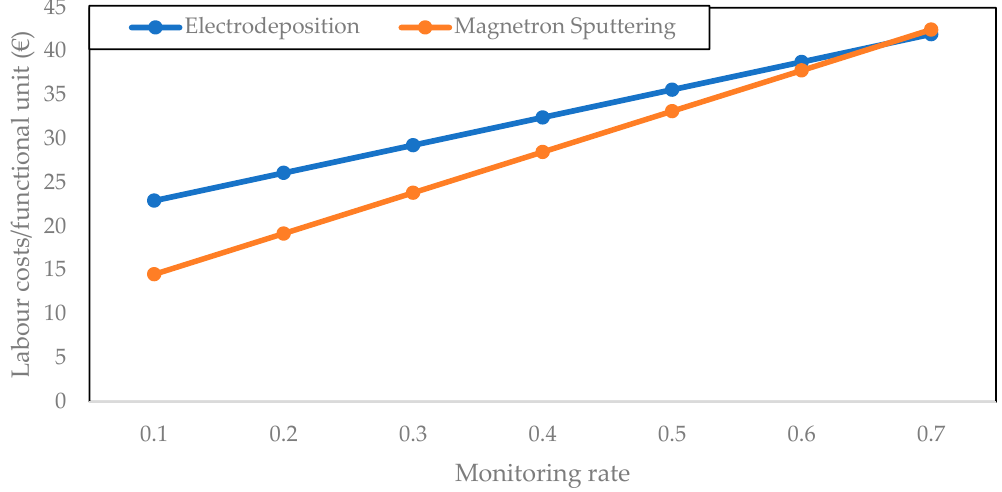
Figure 8. Sensitivity analysis: labor costs increase with monitoring rate.